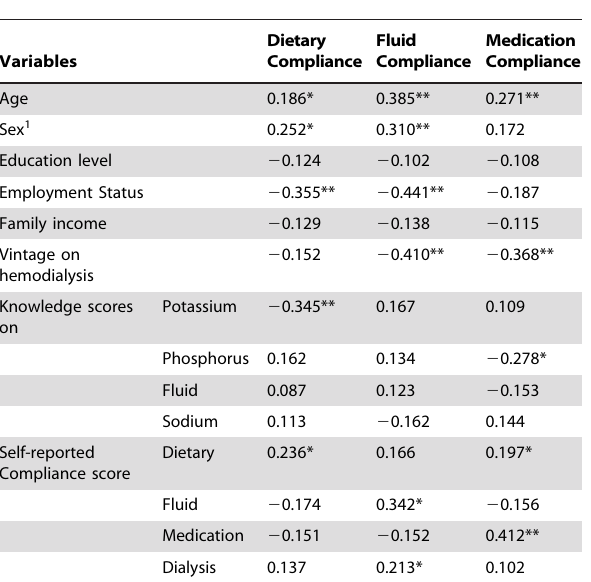
Table 5. Correlation between compliance behaviors and variables.